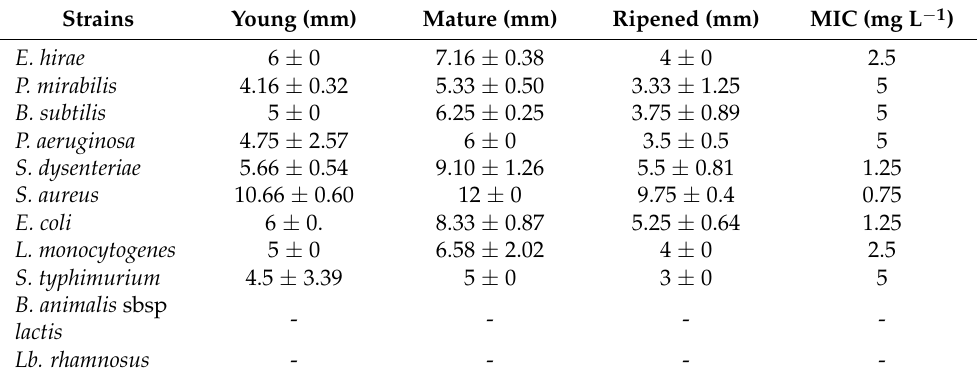
Table 5. Antimicrobial activity of different maturity stages of C. moschata polyphenols. Strains Young (mm) Mature (mm) Ripened (mm) MIC (mg L − 1